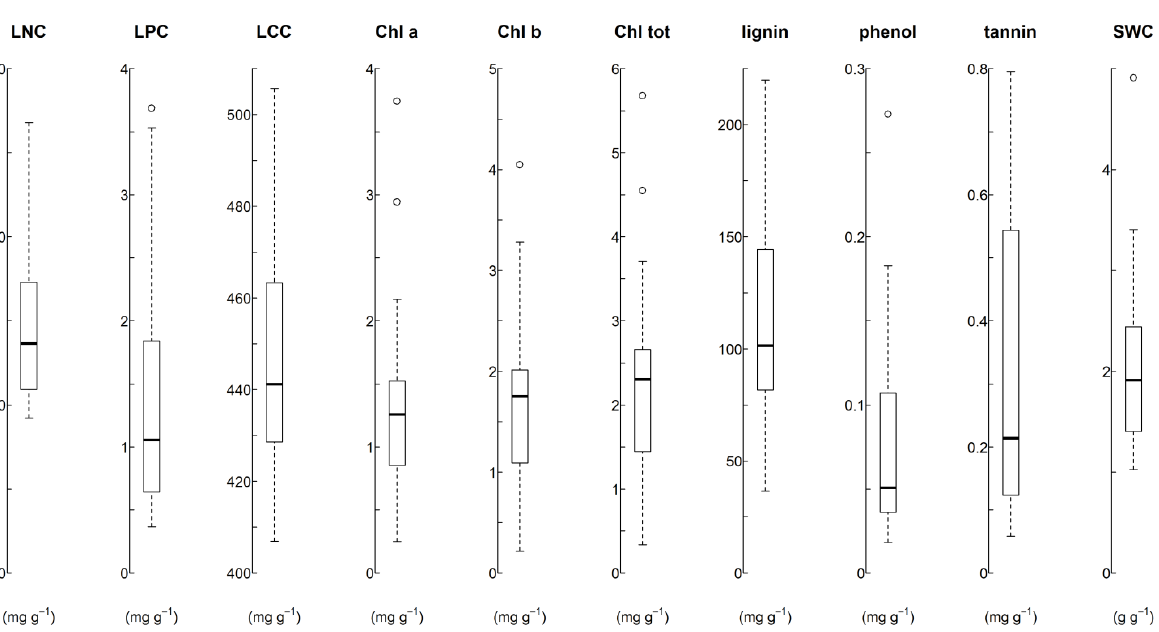
Figure 2. Boxplots of the mass based traits’ distribution, showing median and four quantiles. Total Chl never equals Chl a + Chl b and the difference between (Chl a + Chl b) and total Chl increase with increasing total Chl values (data not